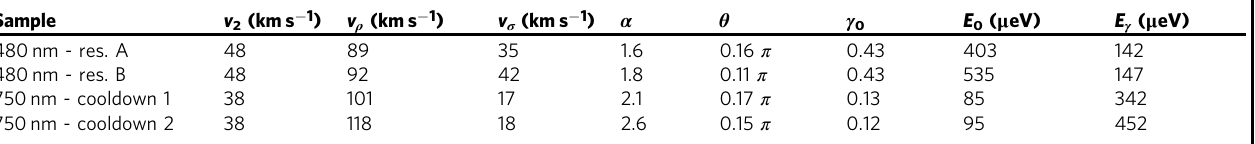
Table 1 TLL fi ts